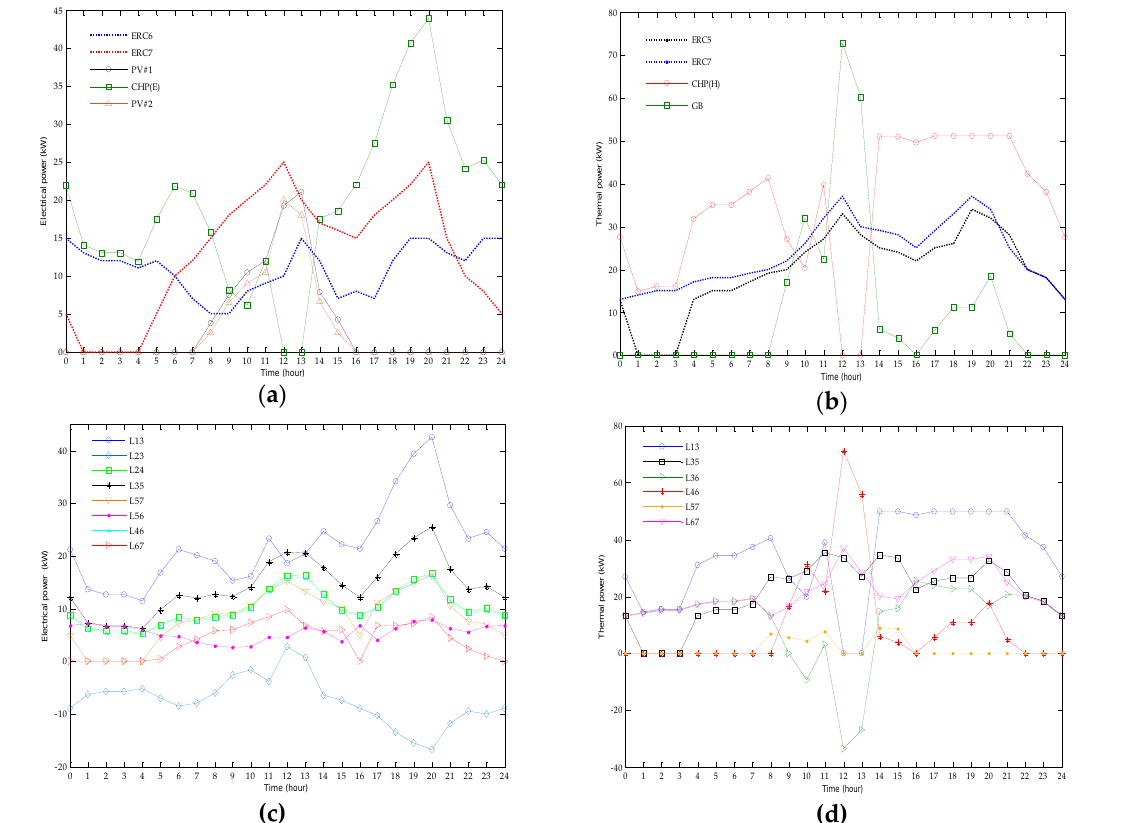
Figure 9. The energy-management-based energy routing strategy. ( a ) Electrical power outputs of devices; ( b ) thermal power outputs of devices; ( c ) electrical power transmitting on connection lines; ( d ) thermal power transmitting on connection pipelines.